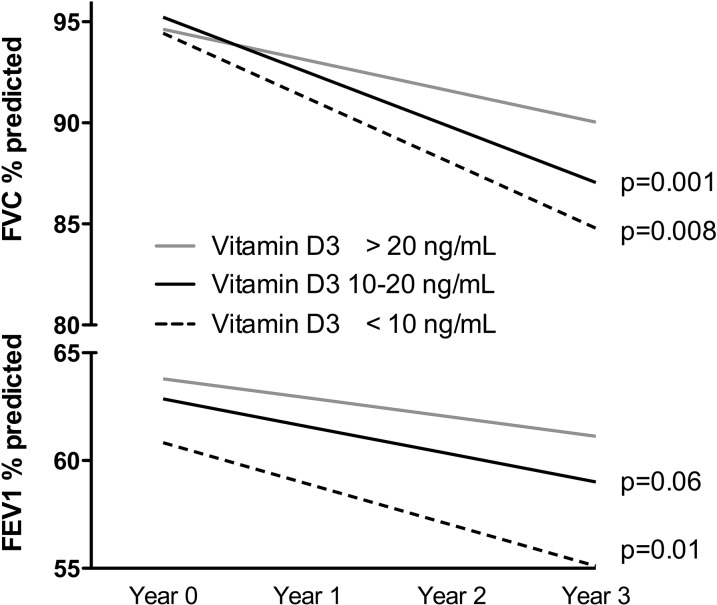
Yearly estimated change in FVC and FEV1 in percent predicted by levels of measured vitamin D at baseline.